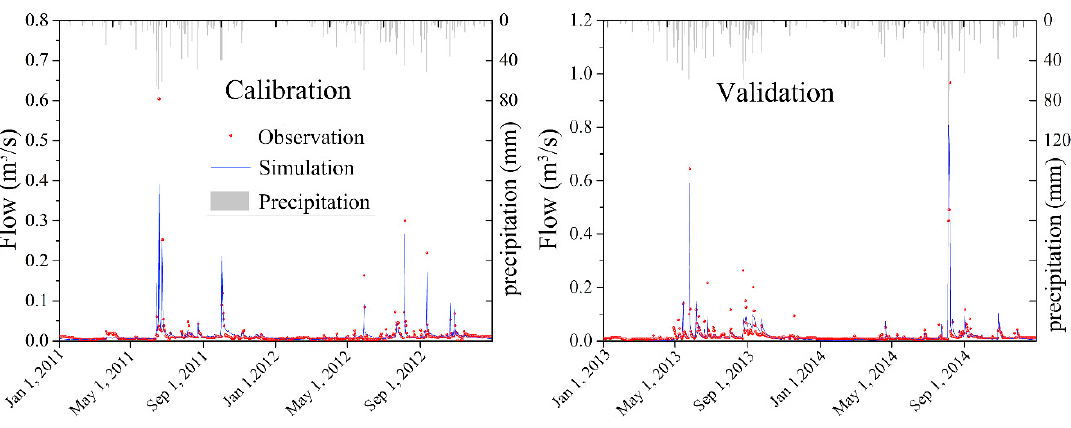
Figure 6. Hyetograph, simulated and observed hydrographs in the calibration and validation periods for the continuous modeling.